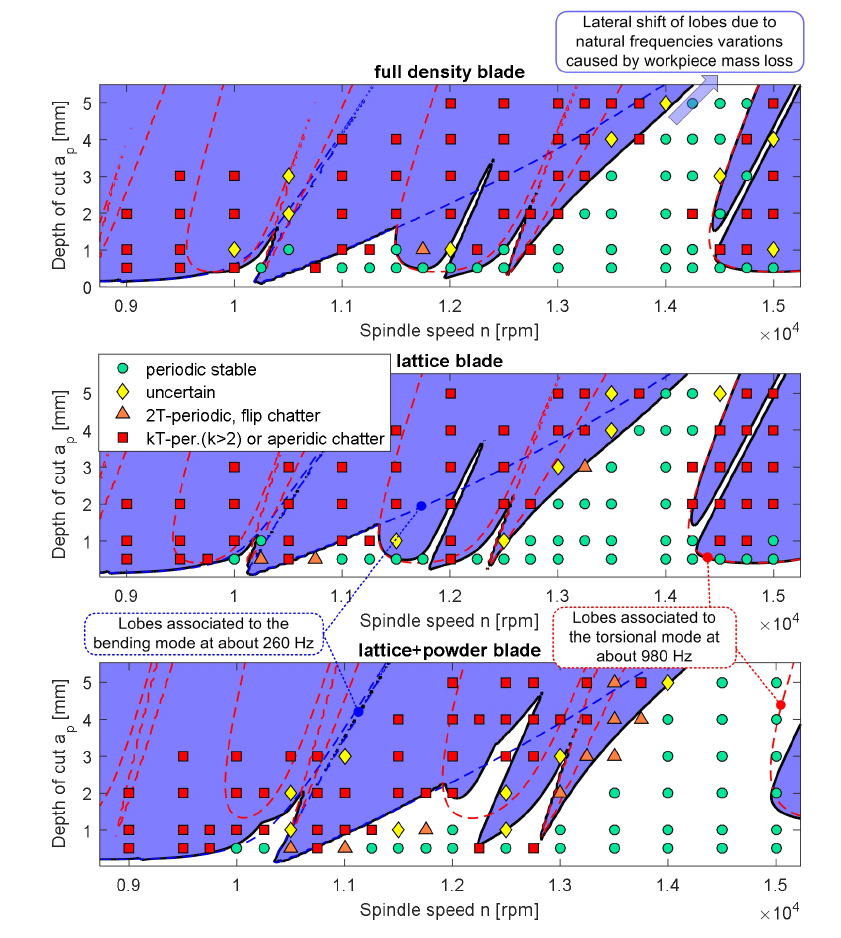
Figure 13. Comparison between experimental and predicted stability lobes, when adopting the full density blade ( top ) the blade with lattice structure ( middle ) and the blade embedding both lattice structure and unmelted powder ( bottom